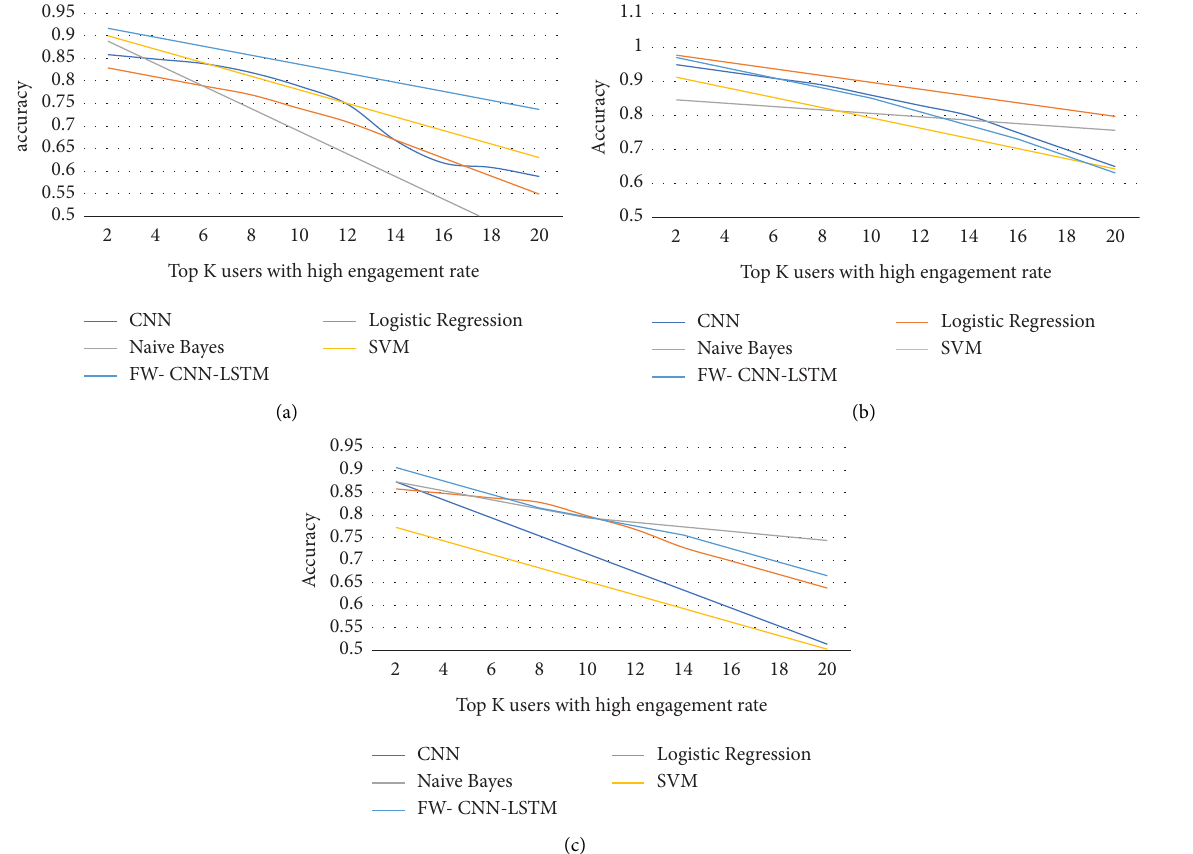
Figure 11: Effect of increasing number of predicting users on accuracy criterion. (a) Taobao dataset. (b) IMDB dataset. (c) Instagram